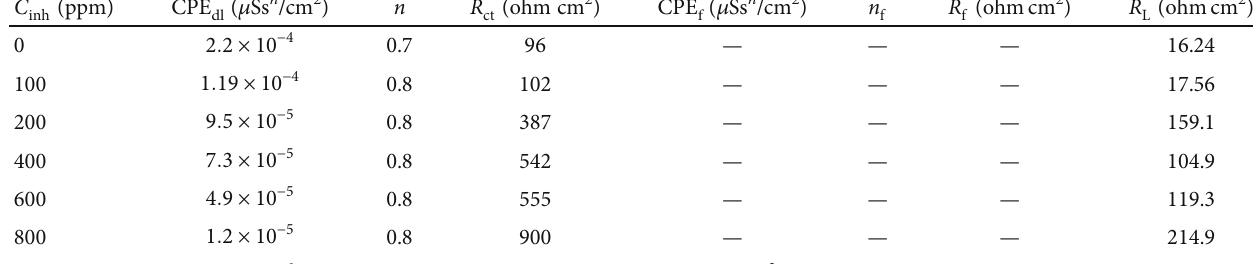
Figure 8: Electric circuits to simulate EIS data for 1018 carbon steel immersed in 0.5M H concentrations of (a) lower than 800ppm and (b) 1000 ppm. Table 4: Electrochemical parameters used to simulate EIS data for carbon steel immersed in 0.5M H metallic complex.